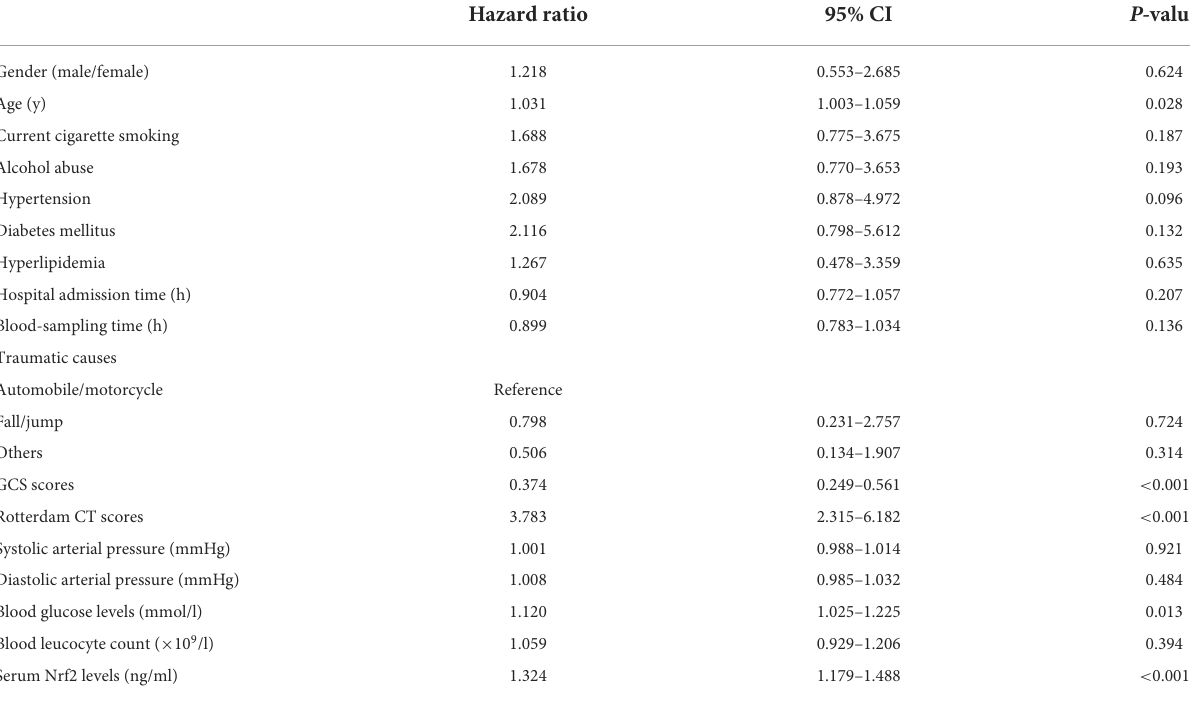
TABLE 3 Factors associated with 180-day overall survival after severe traumatic brain injury. Hazard ratio 95% CI P-